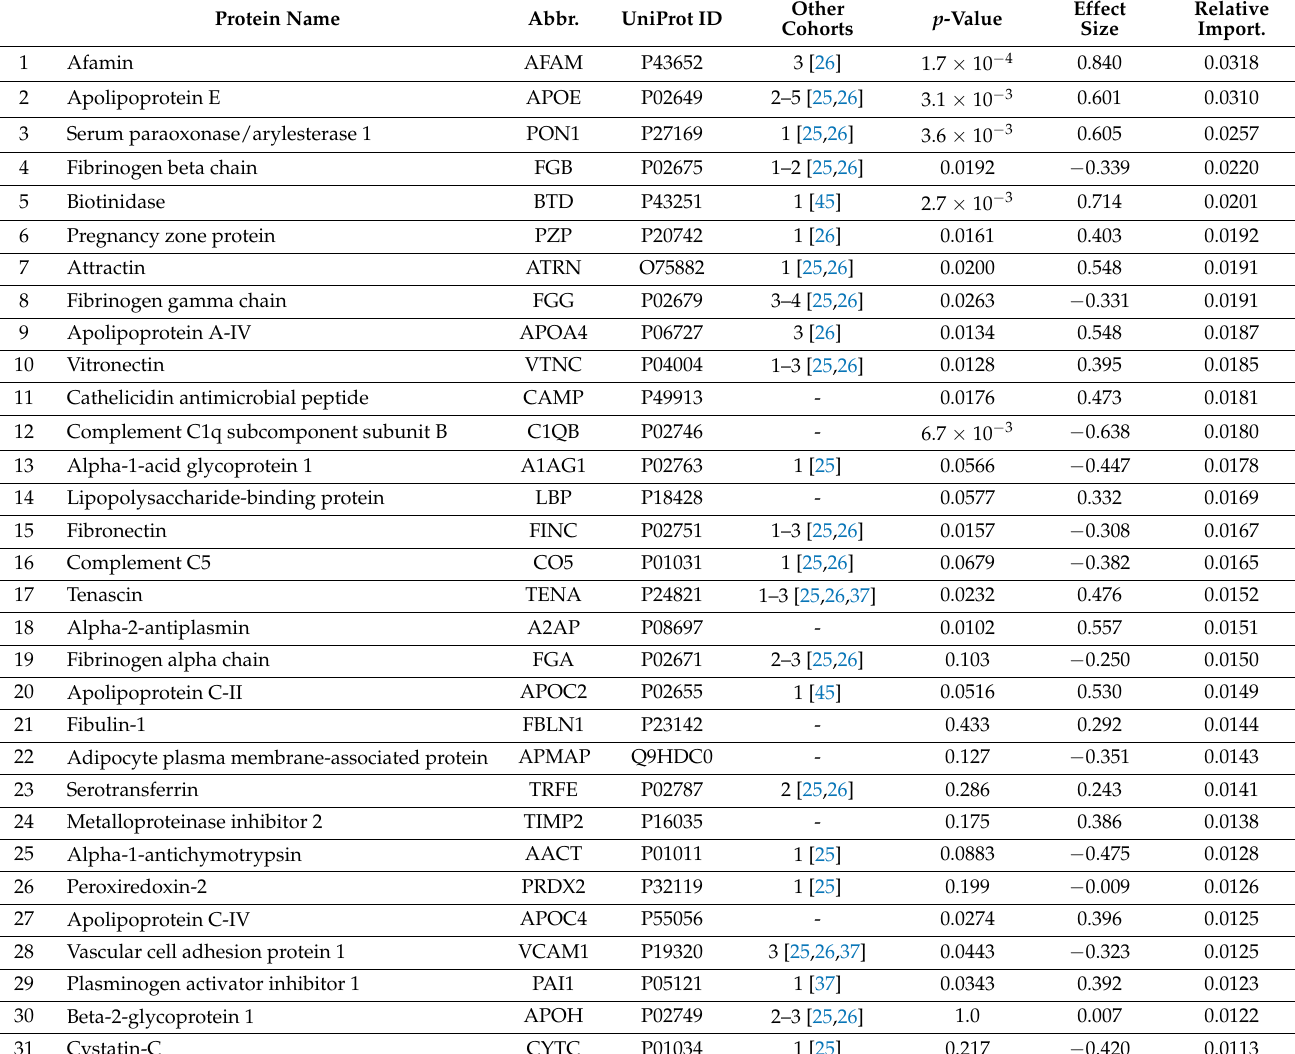
Table 2. Proteins selected in this study for the binary classification of AD vs. the